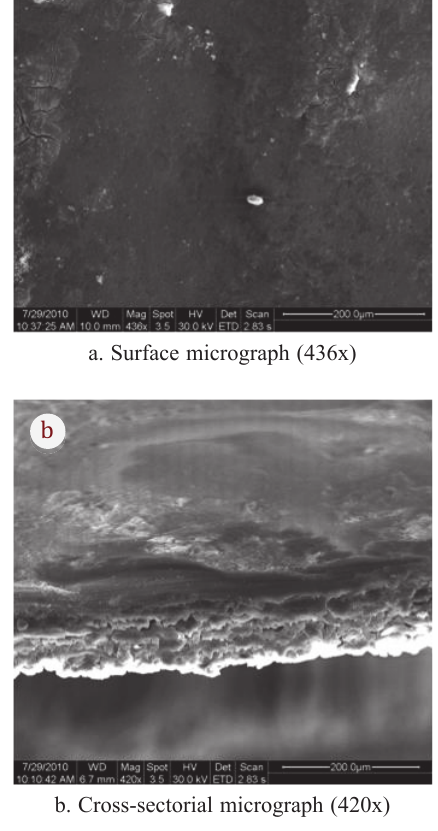
Fig. 7 – Micrographs of the membrane from cleaning 1 in sequential cleaning Fig. 7 Micrographs of the membrane from cleaning 1 in sequential